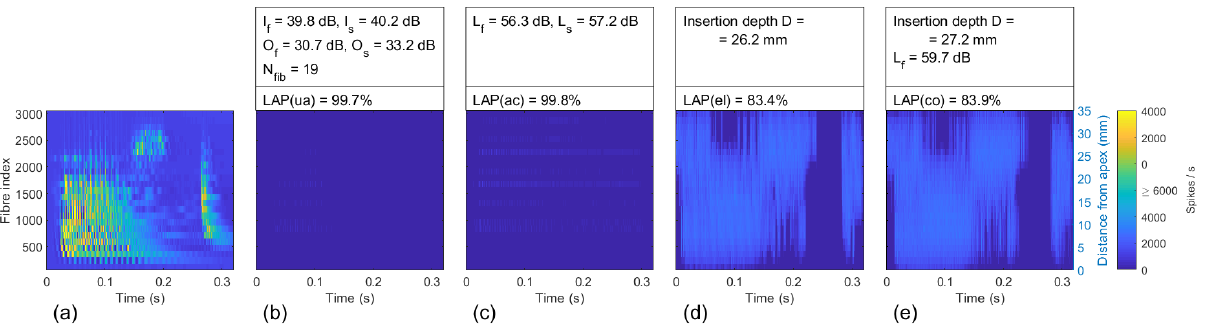
Figure 4. AN firing rates with regard to fiber index and time. The subject has severe IHCL and CGL. The stimulus was an audio recording of a speaker uttering the word ‘nest’, which was scaled to an equivalent sound pressure level of 65 dB (20 µPa). ( a ) Normal hearing reference. ( b ) Unaided hearing, with hearing loss parameters (I f , I s , O f , O s , and N fib ). ( c ) Sole acoustical amplification, with amplification parameters (L f and L s ). ( d ) Sole electrical stimulation, with insertion depth of the CI. ( e ) Electrical stimulation combined with acoustic amplification, with insertion depth of the CI and amplification parameter L f . LAP refers to the cost-adjusted loss of action